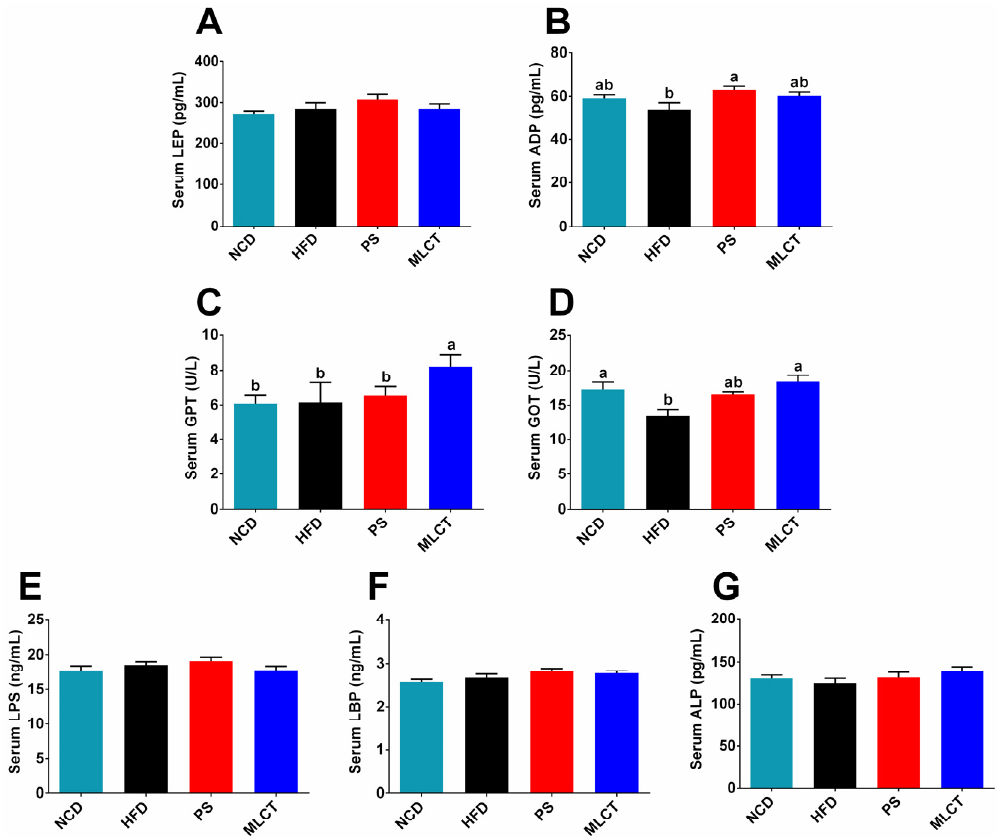
Figure 5. Effects of MLCT on serum hormones and cytokines. ( A ) LEP. ( B ) ADP. ( C ) GPT. ( D ) GOT. ( E ) LPS. ( F ) LBP. ( G ) ALP. Data were shown as mean ± SE ( n = 8). In ( B – D ), means with the different lowercased letters differ significantly ( p < 0.05) according to one-way ANOVA analysis followed by Tukey’s tests.